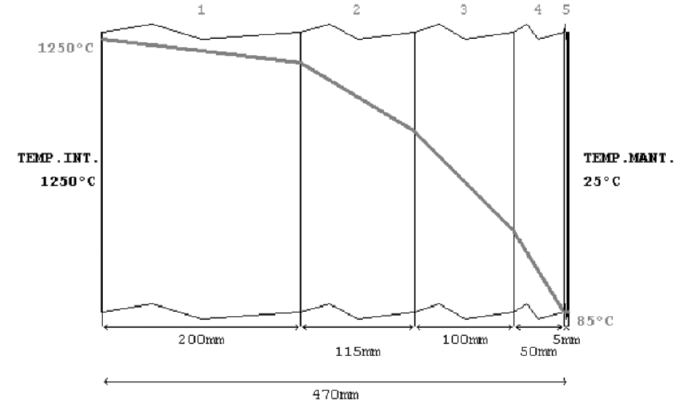
temperature when the furnace is under operating conditions.